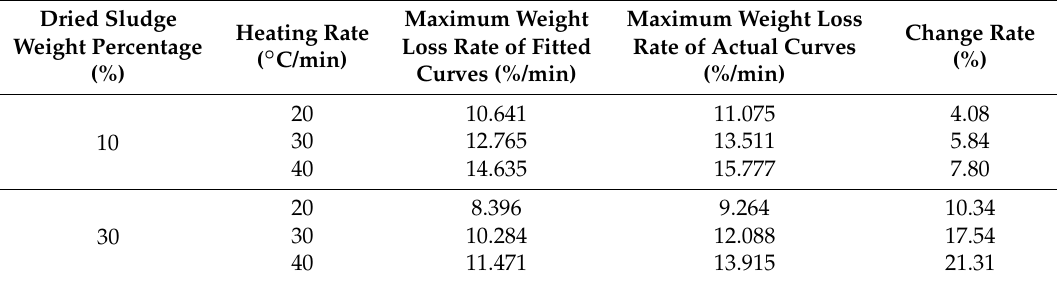
Table 3. Comparison of the maximum weight loss rate of the fitted and actual curves with different heating rate.